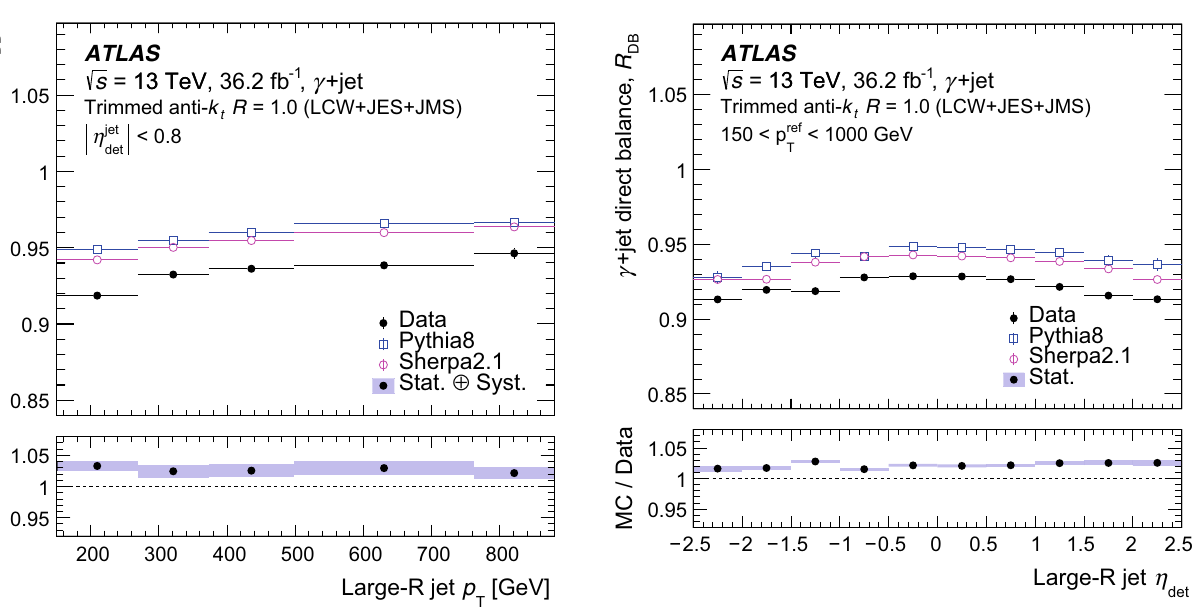
Fig. 10 The momentum balance R DB extracted from γ +jet balance Fig. 9 The momentum balance R DB extracted from γ +jet events in distributions in data and simulation as a function of the large- R jet data and simulations as a function of the transverse momentum p T detector pseudorapidity η det . The ratio of the results obtained from the of the large- R jet. The ratio of the results obtained from the nominal nominal Pythia simulation to the results from data is shown in the Pythia simulation and from data is shown in the bottom panel. The bottom panel. The ratio of Pythia to Sherpa results, taken as a sys- ratio of Pythia to Sherpa results, taken as a systematic uncertainty tematicuncertaintyassociatedwithmodelling, is includedinthe shaded associated with modelling, is included in the shaded band in the ratio band in the ratio panel, which also includes statistical and systematic panel, which also includes statistical and systematic uncertainties from uncertainties from other other sources. For each p ref bin, the measured R DB is plotted against the T average jet p T of the bin. The horizontal error bars give an indication of the width of the associated p ref bin T